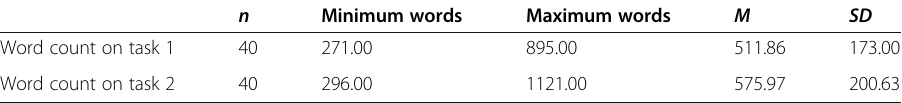
Table 2 The descriptive statistics of the number of words in texts